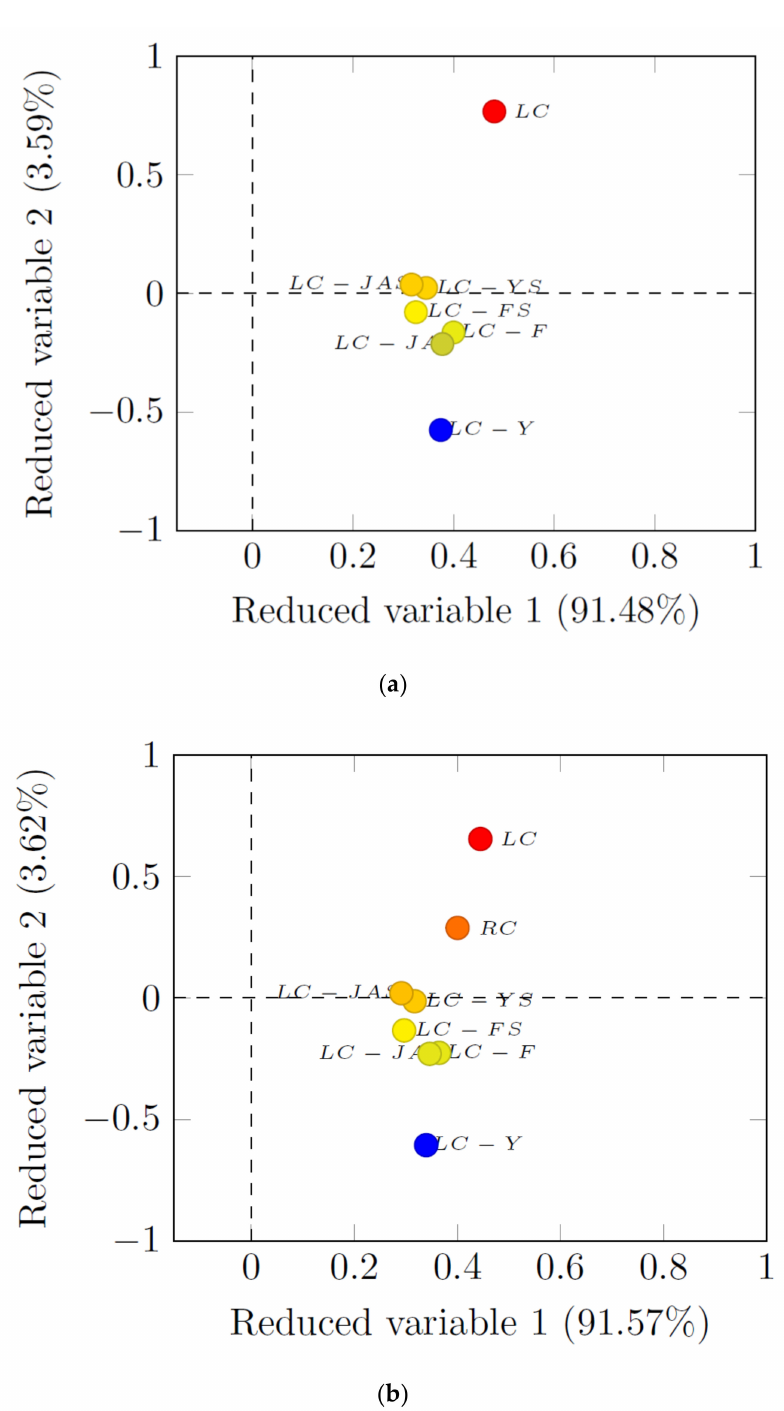
Figure 2. ( a ) Principal component analysis (first version, option 1) with distribution of analyzed samples (LC-groups). ( b ) Principal component analysis (first version, option 2) with distribution of analyzed samples (all groups, including